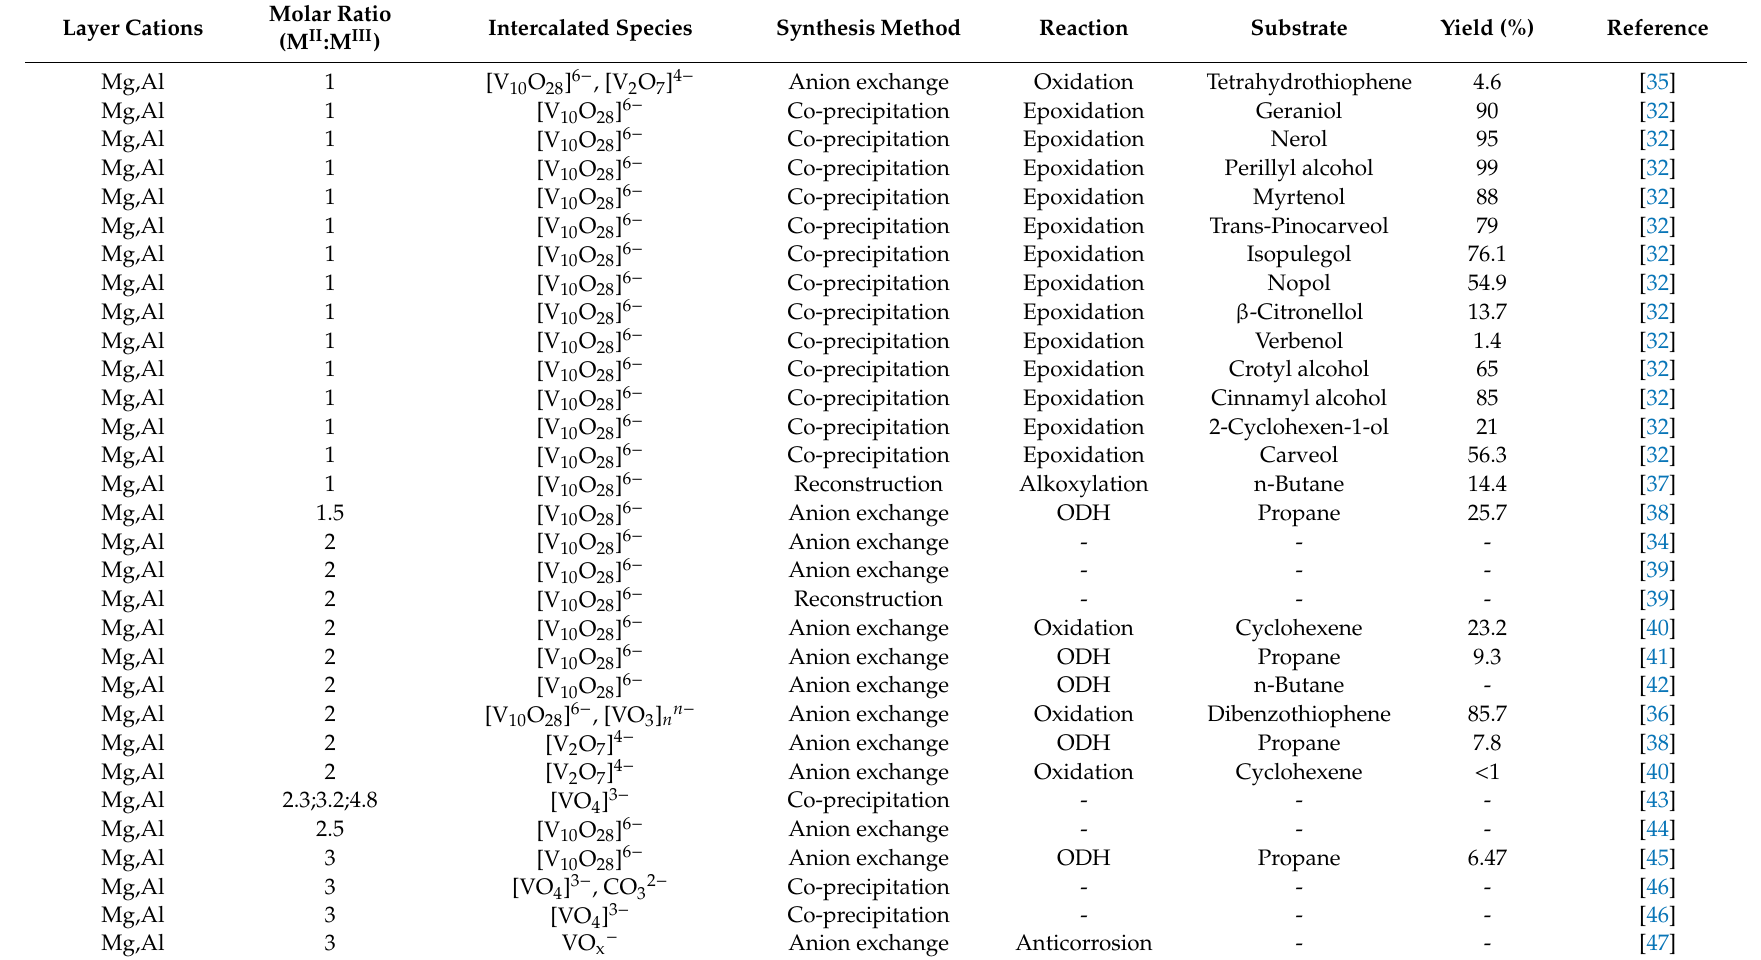
Table 4. Summary of LDH with intercalated vanadium-based